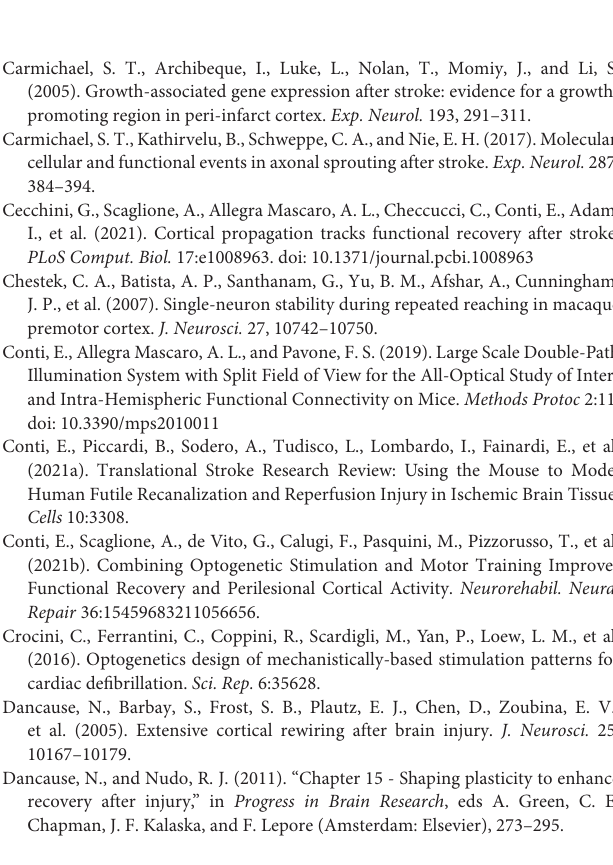
Supplementary Figure 1 | Force and calcium response to the reward pull are similar across weeks for the rehab subjects. (A) Box plots of the force peak for the longitudinal data of the rehabilitated group. (B) Box plots of the fluorescence peak for the longitudinal data of the rehabilitated group. See Figure 2 legend for the description of the plots. Supplementary Figure 2 | Peak detection accuracy of the reward pull is not affected by the experimental group for a loso classification scheme. (A) Box plots of the peak accuracy for the three experimental groups. (B) Box plots of the peak accuracy for the longitudinal data of the rehabilitated group. See Figure 2 legend for the description of the